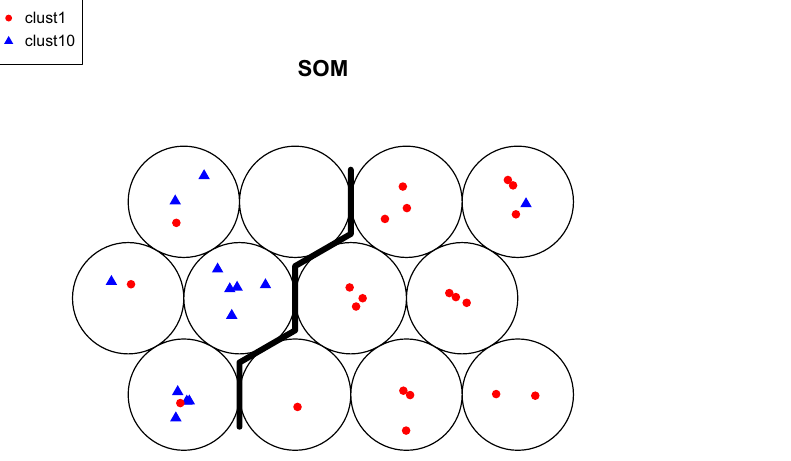
Figure 7. fPCA-based clustering results by SOM.